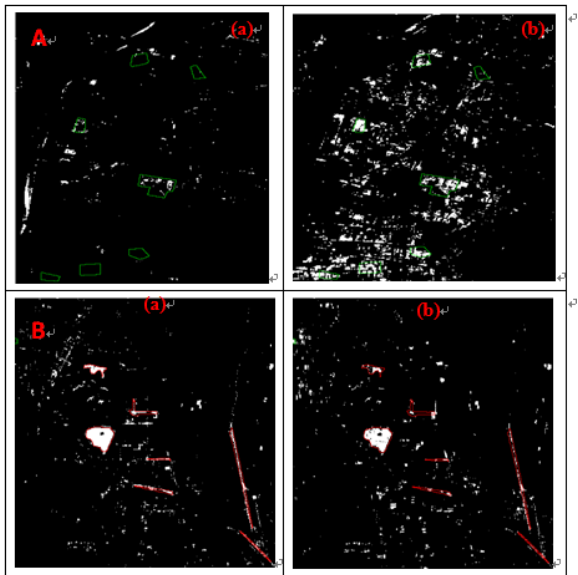
Fig.3. change detection result of LTSM (a), and CVA (b);